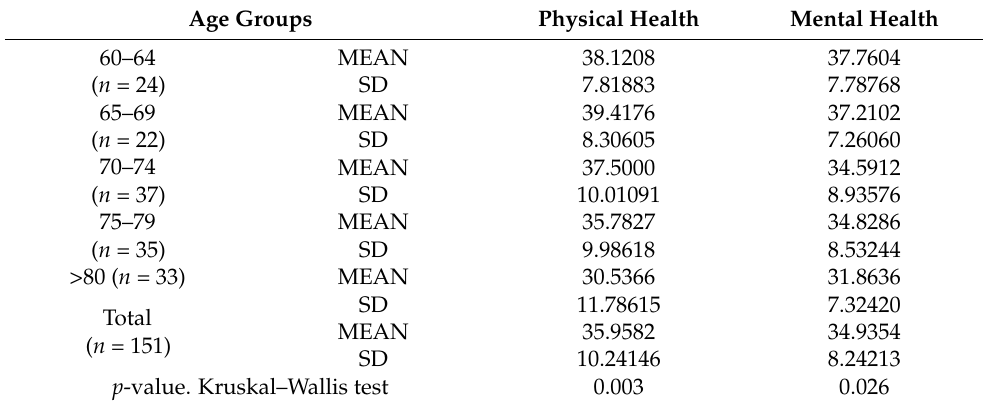
Table 2. Summary Measures according to the Age of Patients Operated on for AAAs.